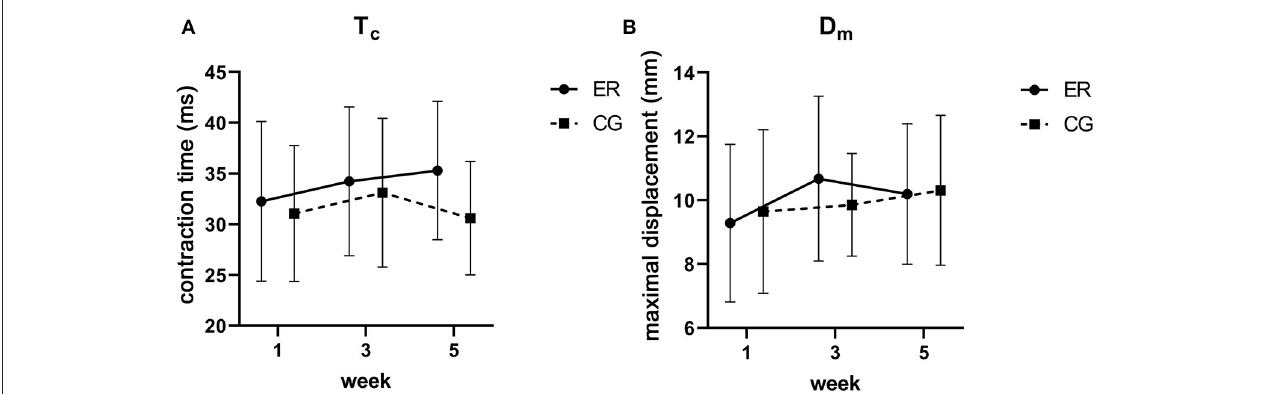
FIGURE 4 | Visual representation of contraction time [T c in ms; (A) ] and maximal displacement (D m in mm) change (B) . Data is plotted as means ± standard deviation. • = energy-restricted group (ER), (cid:4) = control group (CG).